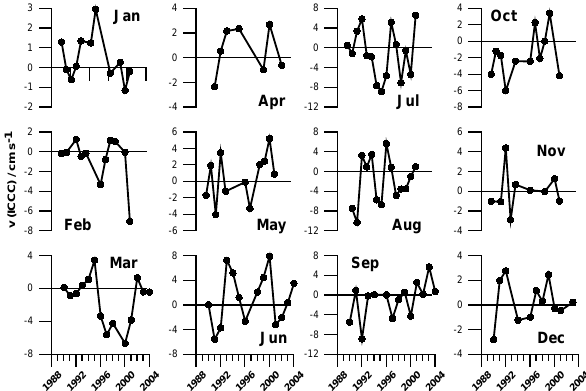
Figure 4. Geostrophic currents relative to 30dbar between stations SJ107 and RV001 in the 1990–2004 period for each month in a year. The ICCC is current of negative